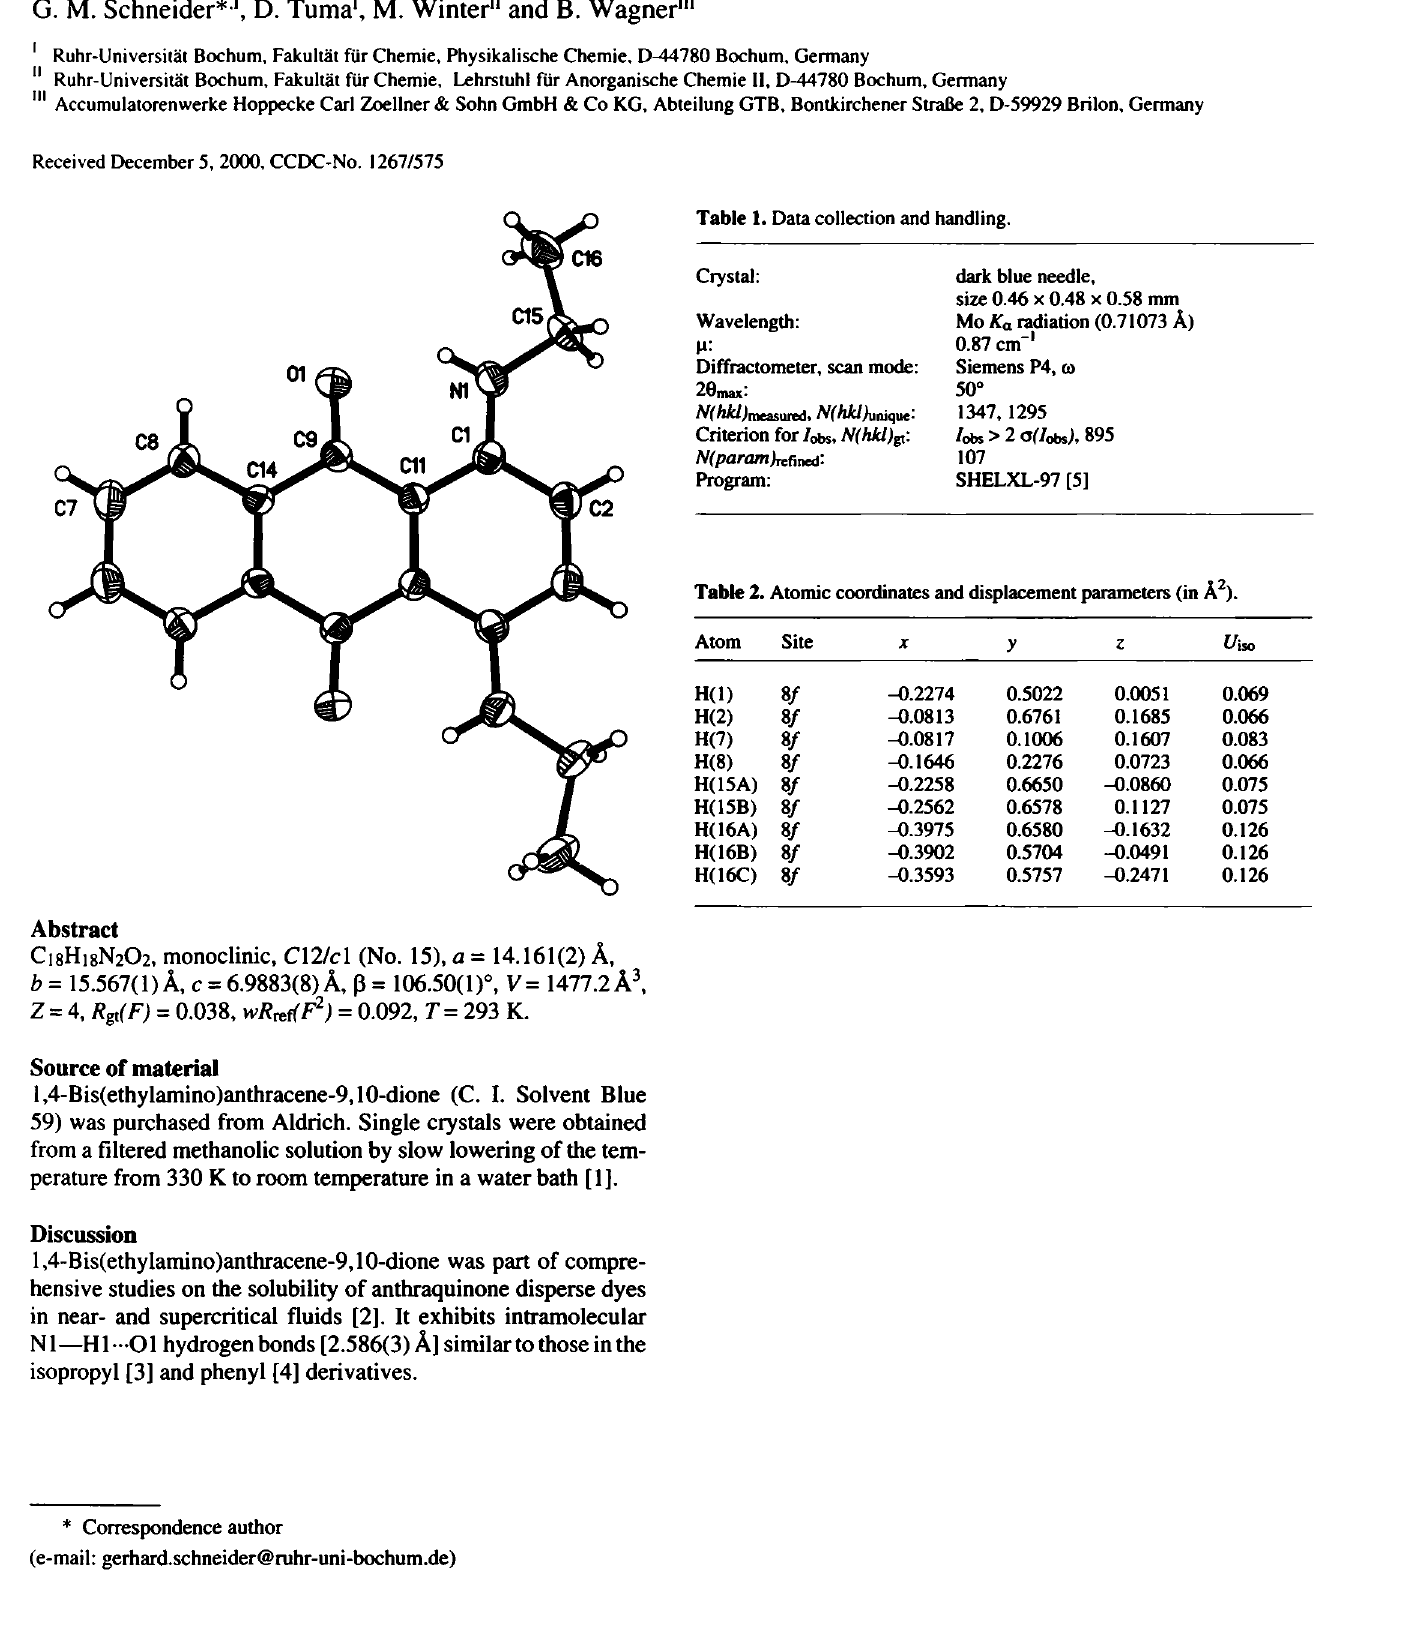
Table 1. Data collection and handling.